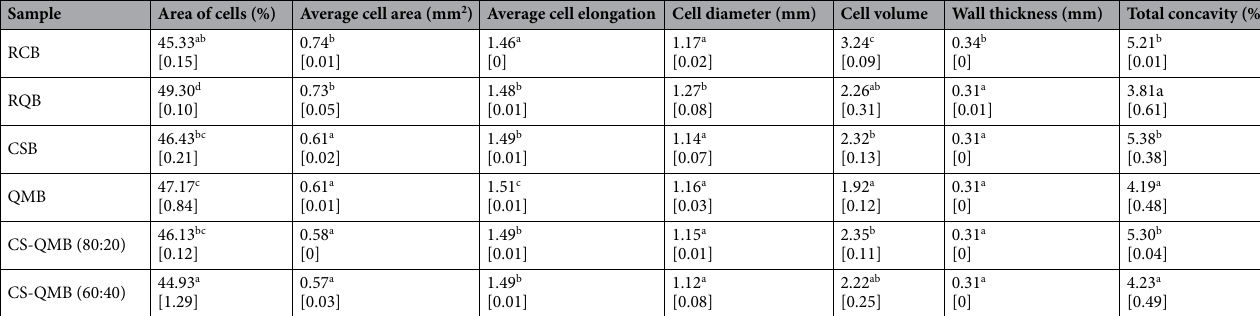
Table 4. Image analyses of the raw, cowpea sourdough, quinoa malt whole and multigrain biscuits. Various superscripts presented per column indicate significant differences ( p ≤ 0.05). Values in square brackets are the standard deviations of the respective means. RCB raw cowpea biscuit, RQB raw quinoa biscuit, CSB cowpea sourdough biscuit, QMB quinoa malt biscuit, CS-QMB (80:20) 80% cowpea sourdough and 20% quinoa malt